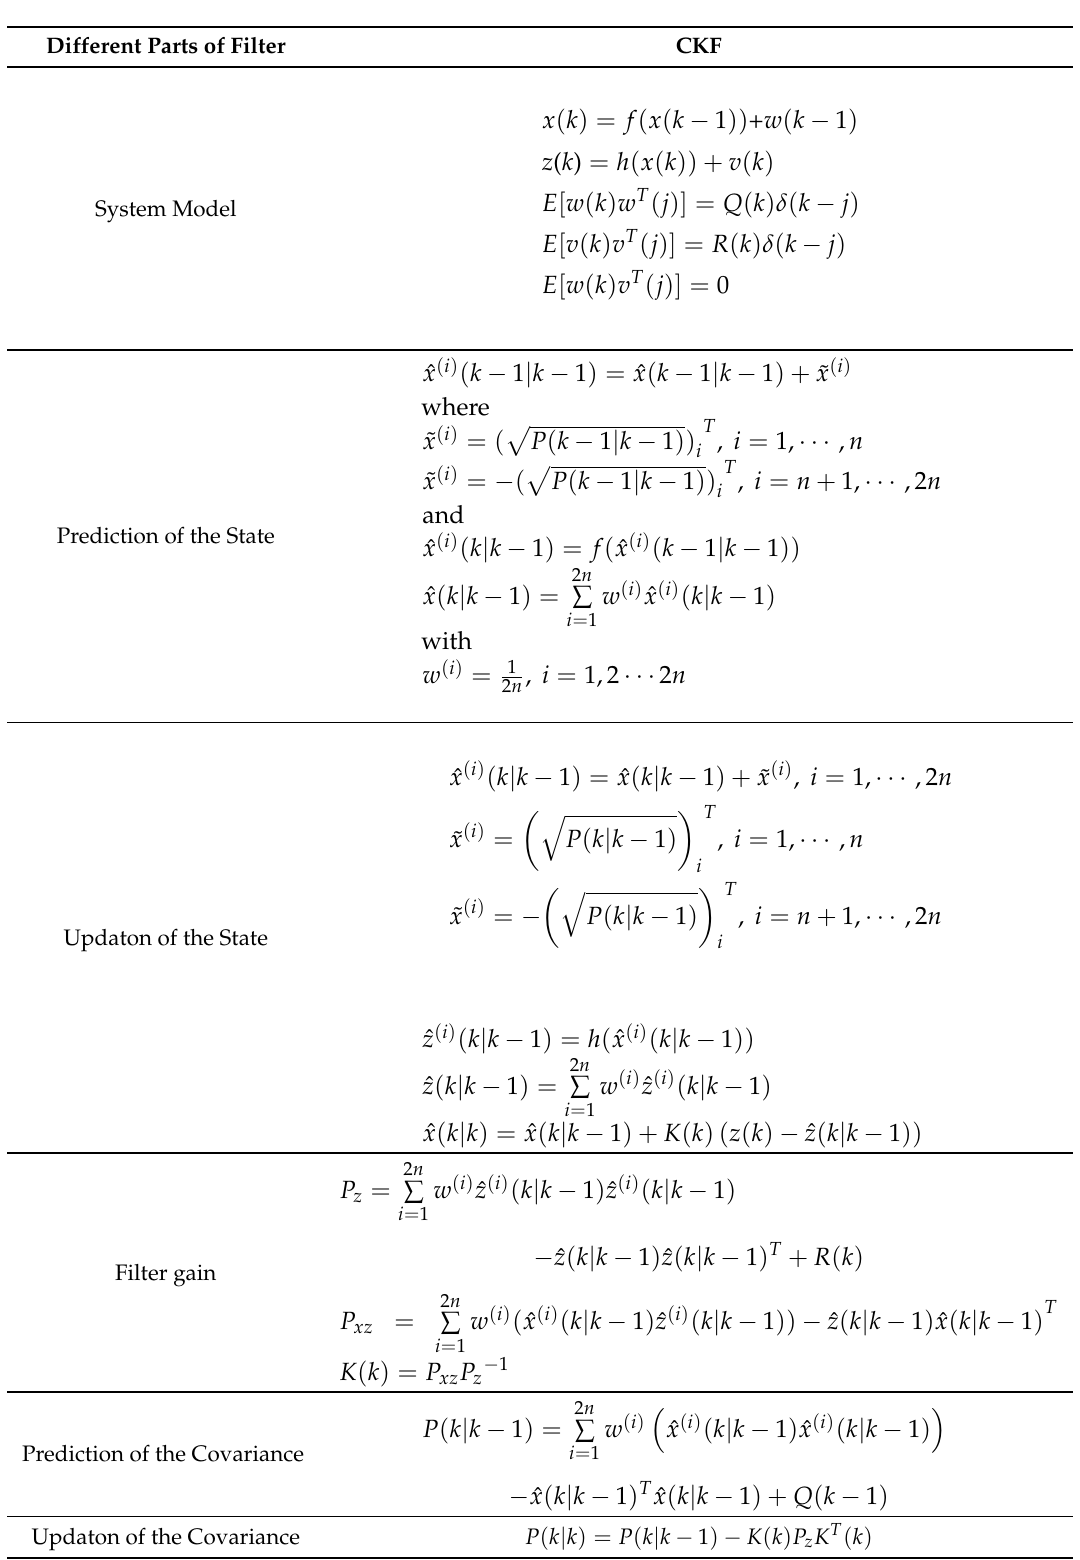
Table A3. The details of